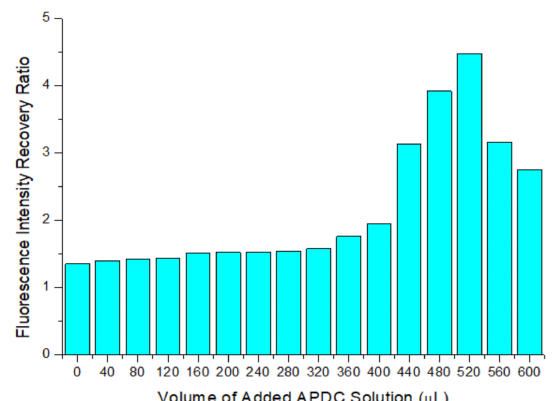
Figure 5. The fluorescence intensity recovery ratio of the etched QD solution with added cadmium standard. Concentration of Tris-HCl bu ff er solution: 10 mmol / L. pH of Tris-HCl bu ff er solution: 8.5.